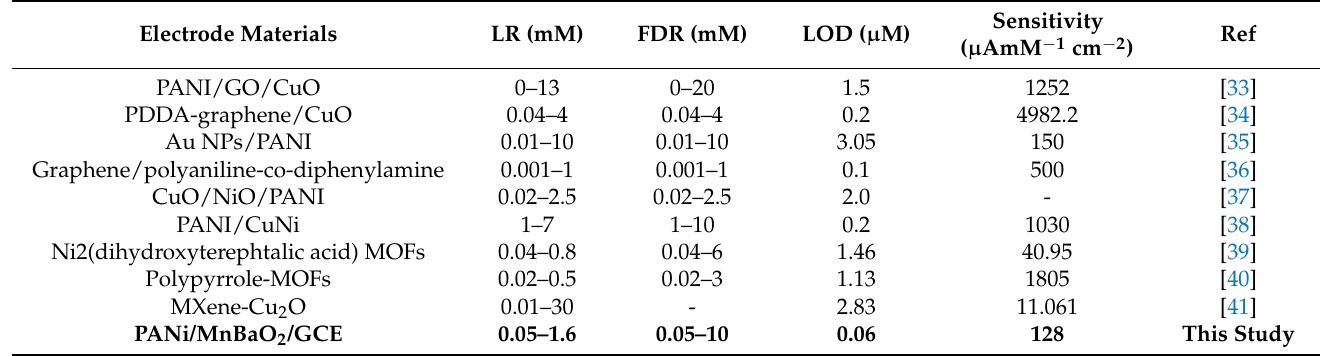
Table 2. Reported current density of the bioanode in the